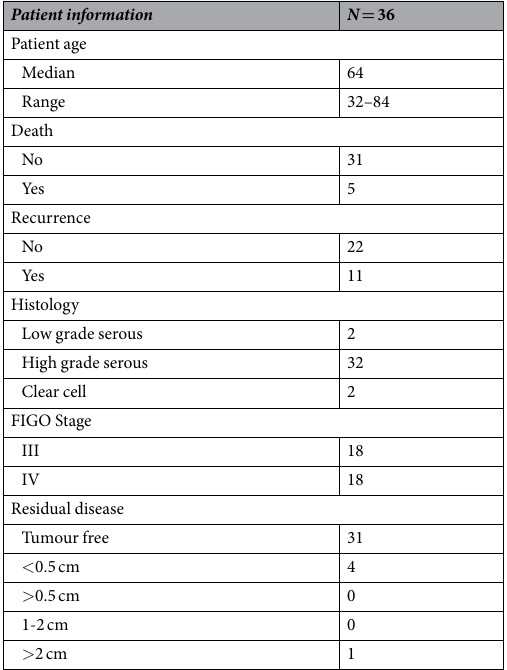
Table 1. Clinical and histological details of all patients enrolled in the study (n =